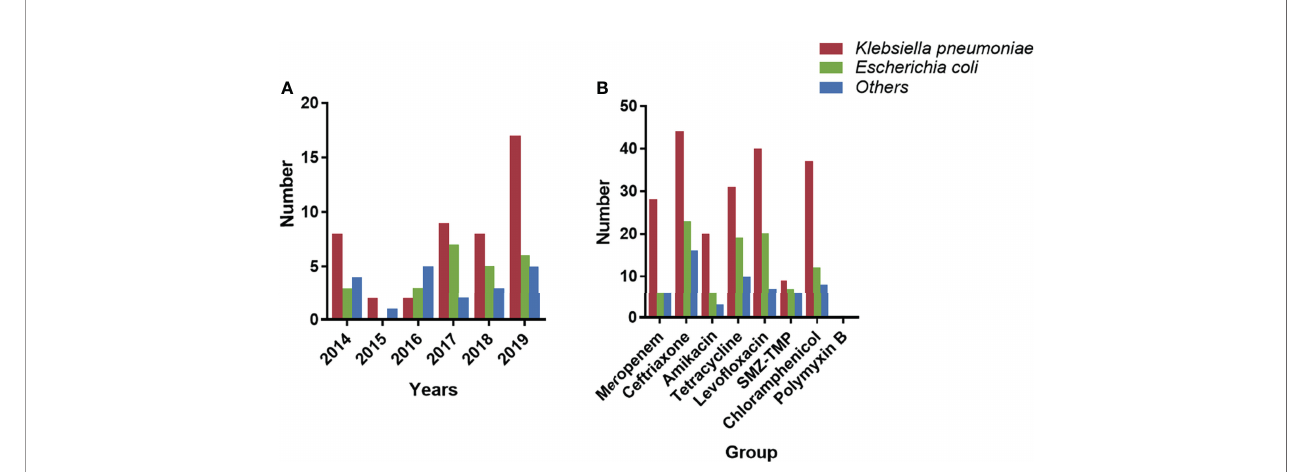
FIGURE 4 | Distribution and AST of the MDRE group. (A) Year-by-year distribution of nosocomial meningitis (NM) caused by MDRE. (B) AST of MDRE. AST , antimicrobial resistance test; MDRE , multidrug-resistant